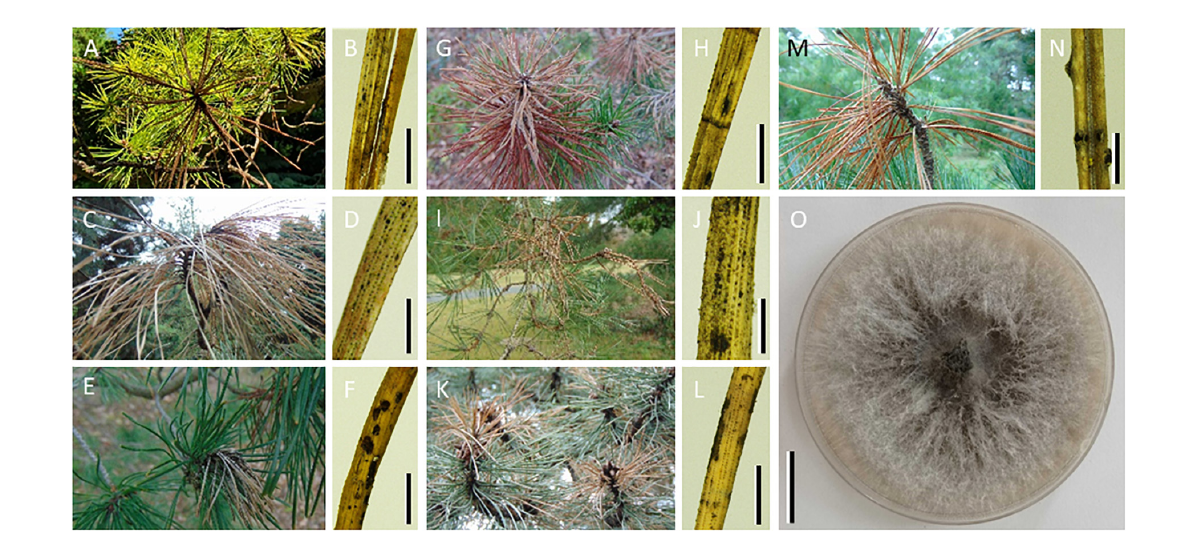
FIGURE1 Photographs of tip blight symptoms across seven pine species where Sphaeropsis sapinea was detected. Macroscopic photographs of shoots with tip blight symptoms (A–G) and of needles from those shoots under stereomicroscope (H–N) collected on Pinus rigida [ (A,B) ; scale bar = 4 mm] Pinus ponderosa [ (C,D) ; scale bar = 2 mm] Pinus mugo [ (E,F) ; scale bar = 4 mm] Pinus uncinata subsp. rotundata [ (G,H) ; scale bar = 4 mm] Pinus sylvestris [ (I,J) ; scale bar = 2 mm] Pinus nigra [ (K,L) ; scale bar = 4 mm] Pinus cembra [ (M,N) ; scale bar = 750 µ m] trees tested positive